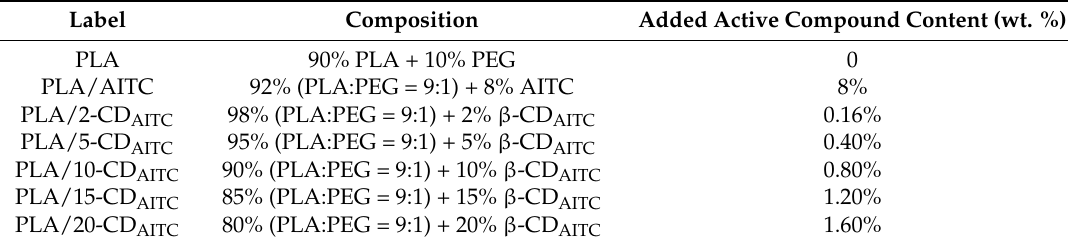
Table 1. Composition and labels of antimicrobial